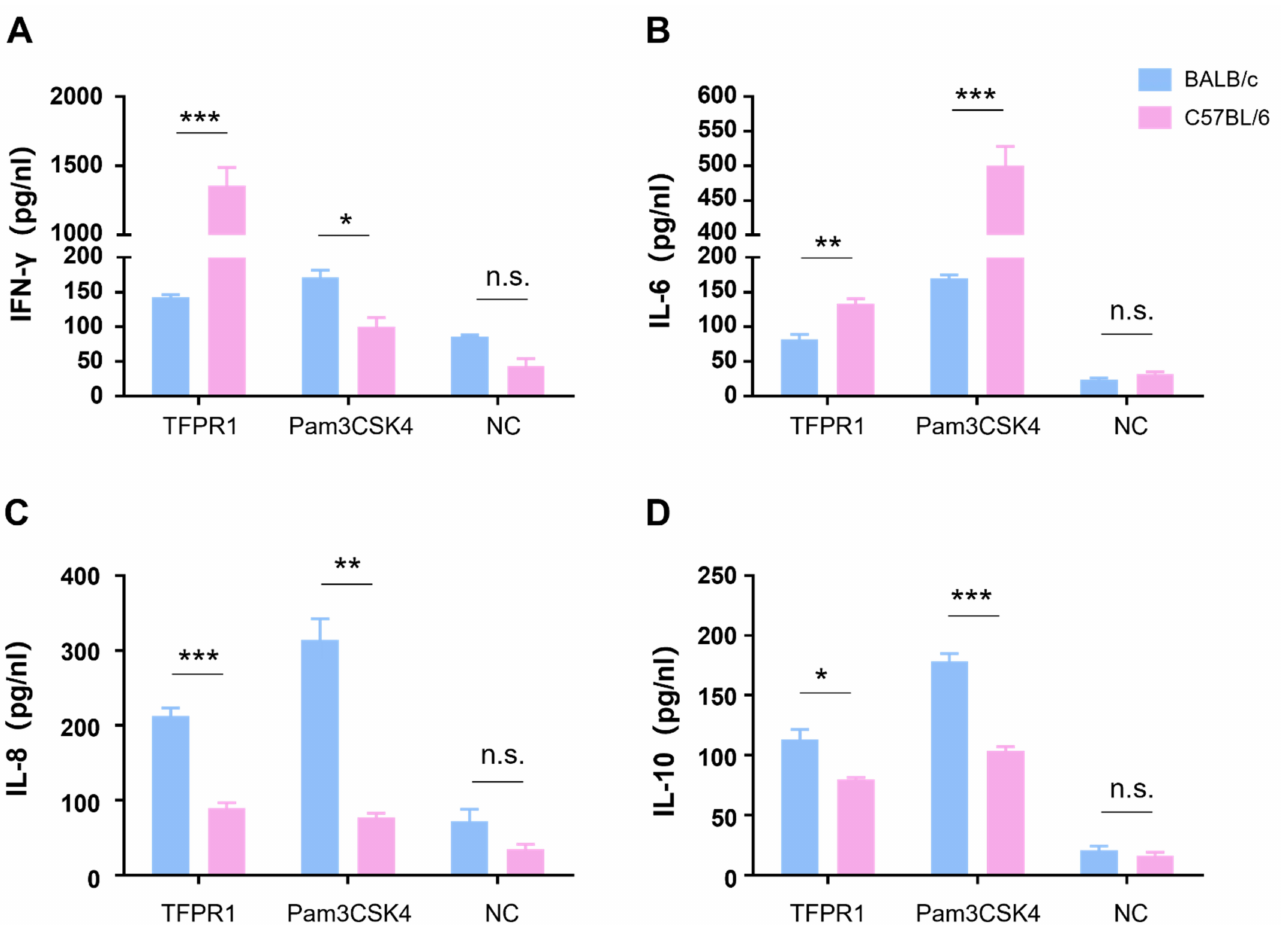
Figure 2. Detection of cytokines secreted by splenocytes from BALB/c and C57BL/6 mice. Splenocytes either from BALB/c or C57BL/6 mice were stimulated with TFPR1 or Pam3CSK4 for 24 h, and cytokines in culture supernatants were measured using ELISA kits. ( A ) IFN- γ . ( B ) IL-6. ( C ) IL-8. ( D ) IL-10. Note: * stands for p < 0.05, ** p < 0.01, and *** p < 0.001. n.s.: no